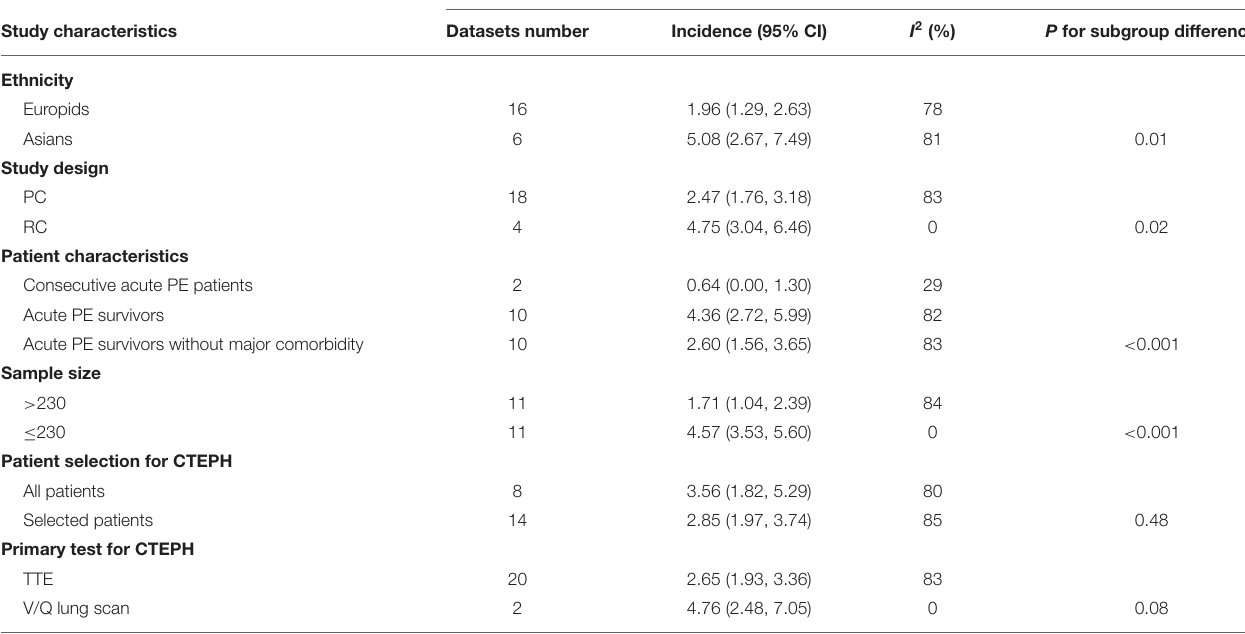
TABLE 3 | Subgroup